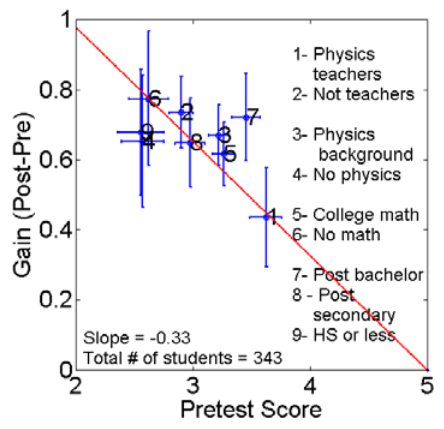
Figure 2 . The negative slope of the red line, constrained to go through the point (5,0), indicates the normalized gain that best fits the 343 students who answered all 5 non- force-related items on both pre and post tests. The mean pretest and gain scores, with standard errors, are also shown for various